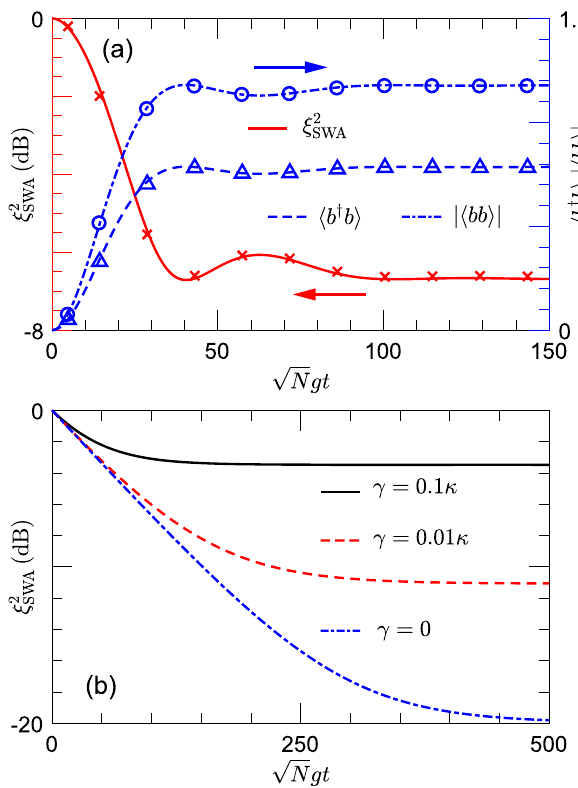
Figure 4: (a) Comparison between the effective (curves) and full (symbols) Hamiltonians under the spin-wave approximation. The spin-squeezing parameter ( ξ 2 , left red axis) and the two-atom SWA correlation ( | 〈 bb 〉 | , right blue axis) are shown. We have set ω ≈ ω − ω + Ng 2 / Δ m c q c .Thisyieldsanexcellentagreement.(b)Spin- squeezing parameter ξ 2 given in Eq. (14) for G + / G − (cid:2) 0 . 98. In SWA (a)weset: Δ c (cid:2) 200 κ , Ω (cid:2) 0 . 1 Δ c , A m (cid:2) 0 . 15 ω m , γ (cid:2) 0 . 01 κ ;andinboth (cid:7)(cid:7) √ plots: N g (cid:2) 10 κ